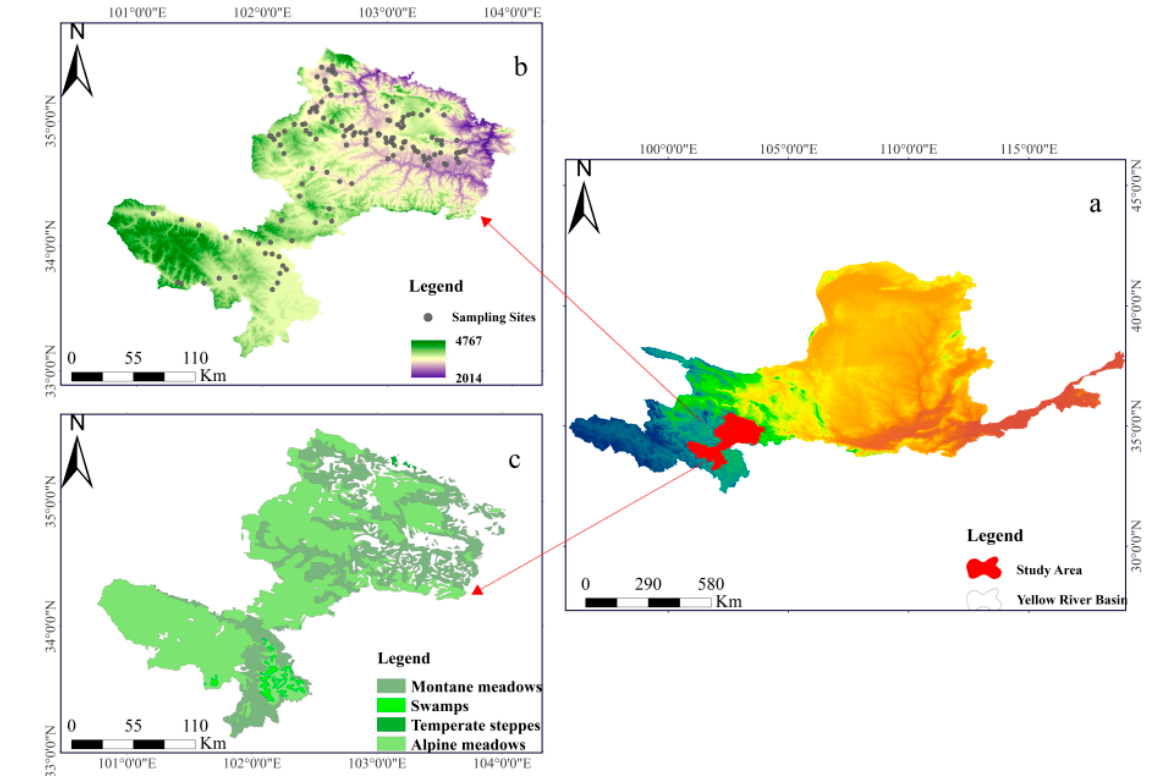
Figure 1. Geographical map of the study area. ( a ) the location of the study area, ( b ) the distribution of sampling points, and ( c ) the four main types of grasslands.